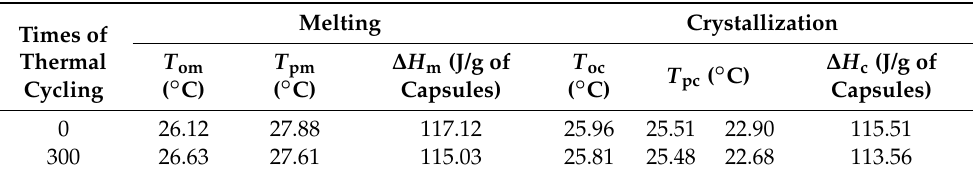
Figure 9. DSC thermograms of the M-NEPCMs before and after thermal cycling 300 times. Table 8. Thermal properties of M-NEPCMs (Sample 4) before and after thermal cycling 300 Table 8. Thermal properties of M ‐ NEPCMs (Sample 4) before and after thermal cycling 300 times.